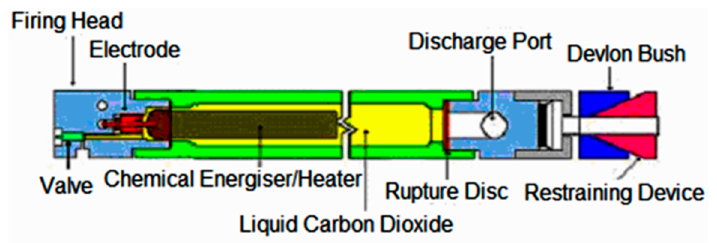
Figure 1. Schematic diagram of a Cardox system [6].